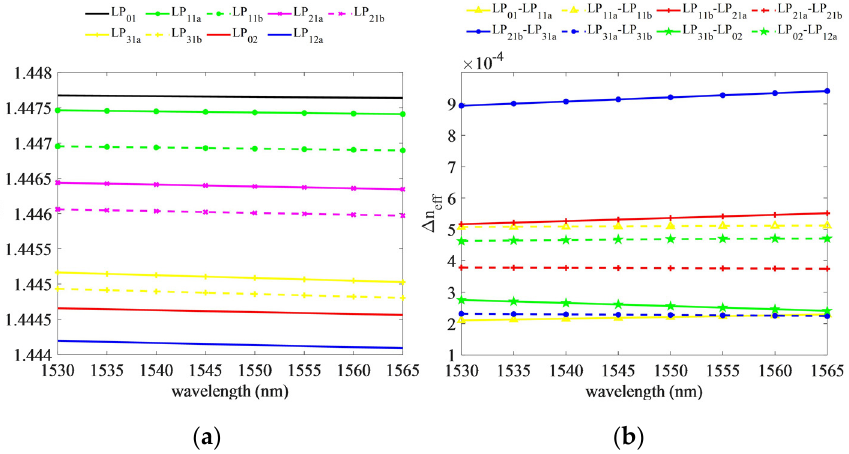
Figure 2. The calculated ( a ) effective refractive index (n eff ) and ( b ) effective refractive index difference ( Δ n eff ) of diamond − assisted ring − core fiber for different modes.